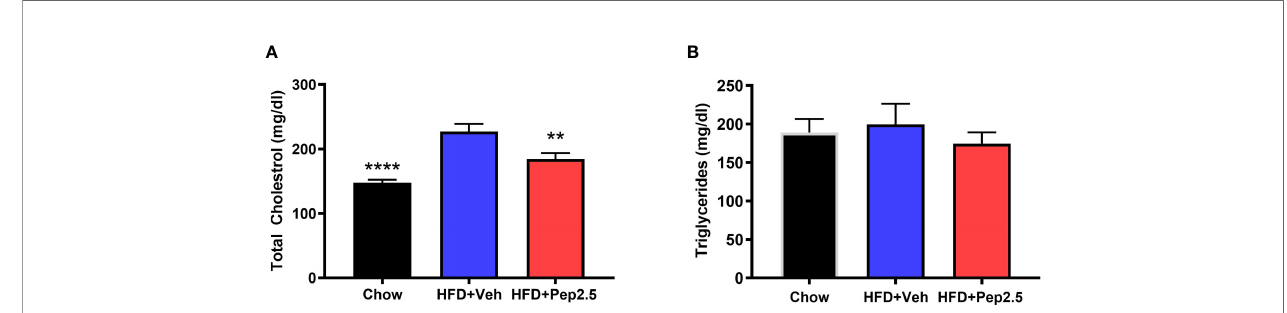
FIGURE 3 | Peptide 19-2.5 attenuates hypercholesterolemia in HFD-fed mice. Serum samples were collected at the end of the experiment to measure (A) total cholesterol (mg/dl) and (B) triglycerides (mg/dl). Data was analyzed by one-way ANOVA, with Bonferroni post-hoc test. Data are expressed as mean ± SEM; n = 10